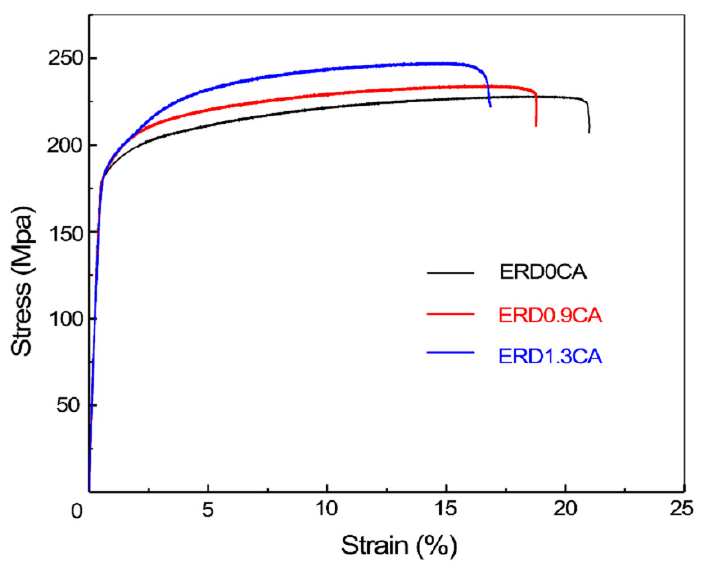
Figure 2. Typical stress–strain curves of pre-strained samples under tension along extrusion direction (ED) of magnesium alloy rod. Table 1. Yield stress (0.2% proof stress) and stresses corresponding to different strains and elongation of the samples with and without pre-strain during tension along extrusion direction. Before tension, all these samples are annealed. The pre-strains for the three kinds of samples are 0 (ERD0CA), 0.9% (ERD.09CA) and 1.3% (ERD0CA),